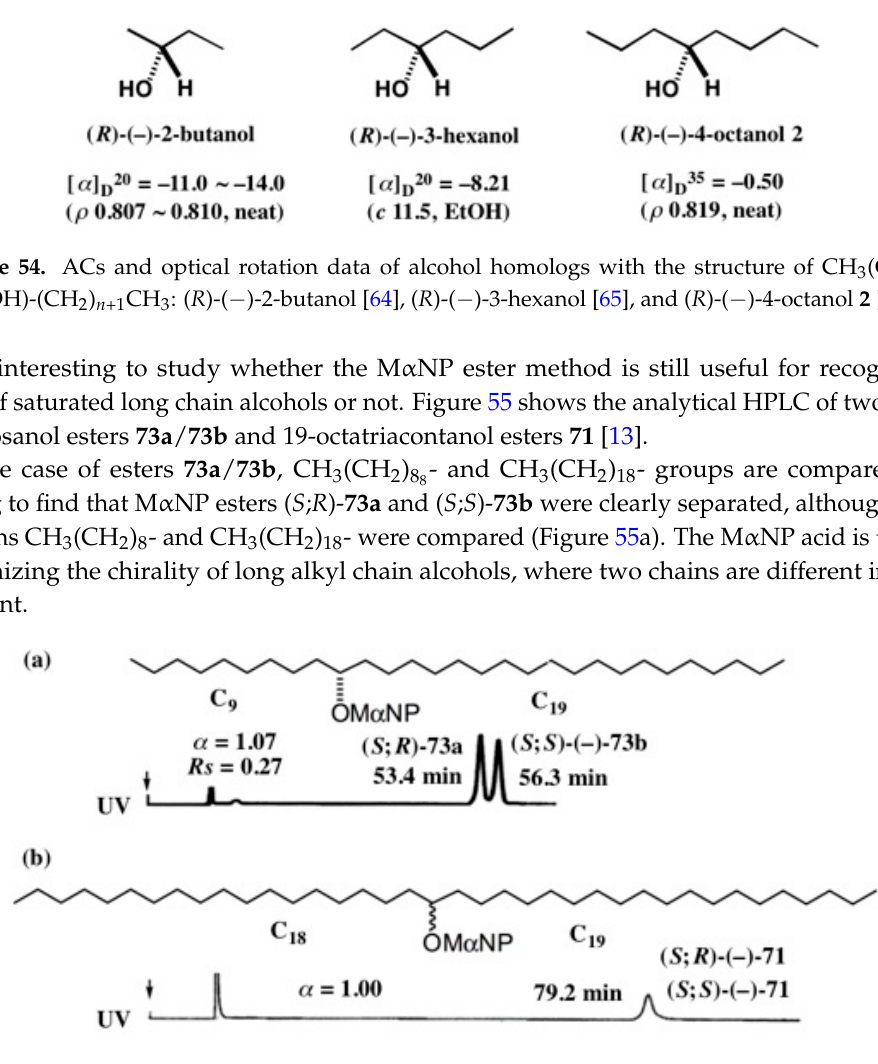
Figure 55. Analytical HPLC of saturated long chain alcohols M α NP esters: silica gel column (10 φ × 300 mm, n = 34,400); sample (0.1 mg); detected by UV. ( a ) hexane/EtOAc 80:1; ( b ) hexane/EtOAc 150:1. Redrawn with permission from [13].